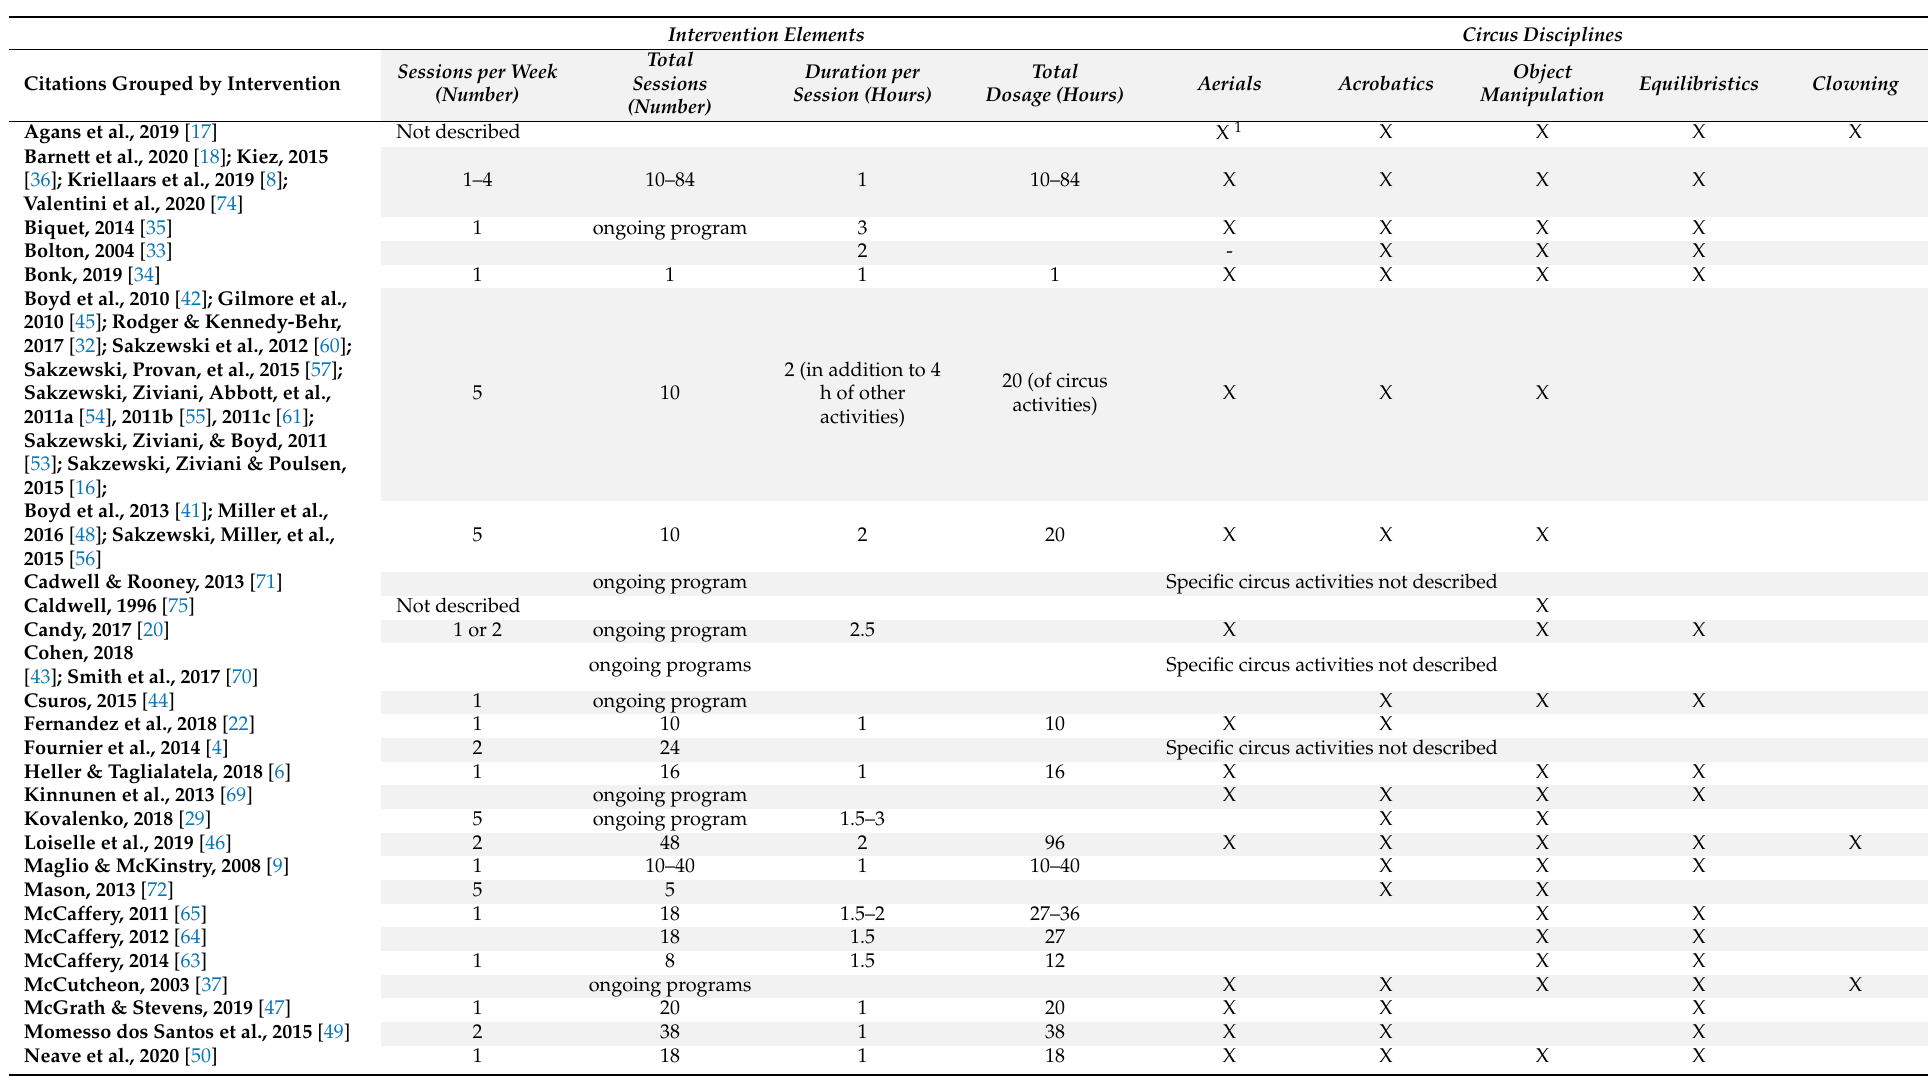
Table 1. Characteristics of the circus